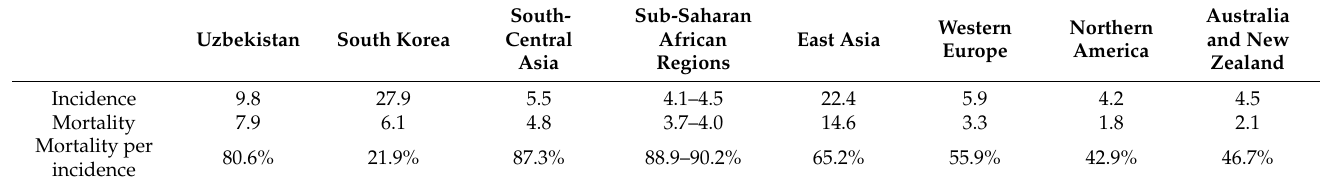
Table 1. Brief global statistics of stomach cancer, including Uzbekistan and South